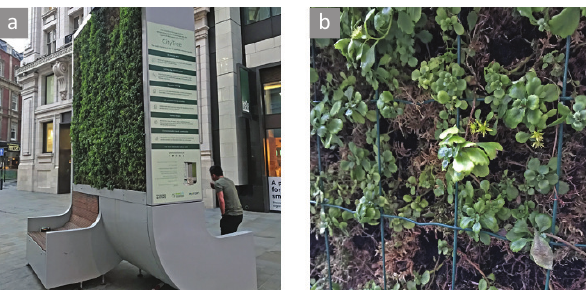
Figure 7. CityTree moss vertical infrastructure in London: (a) general view; (b) detail of moss and plants arrangement. selection for green infrastructure, nonetheless,